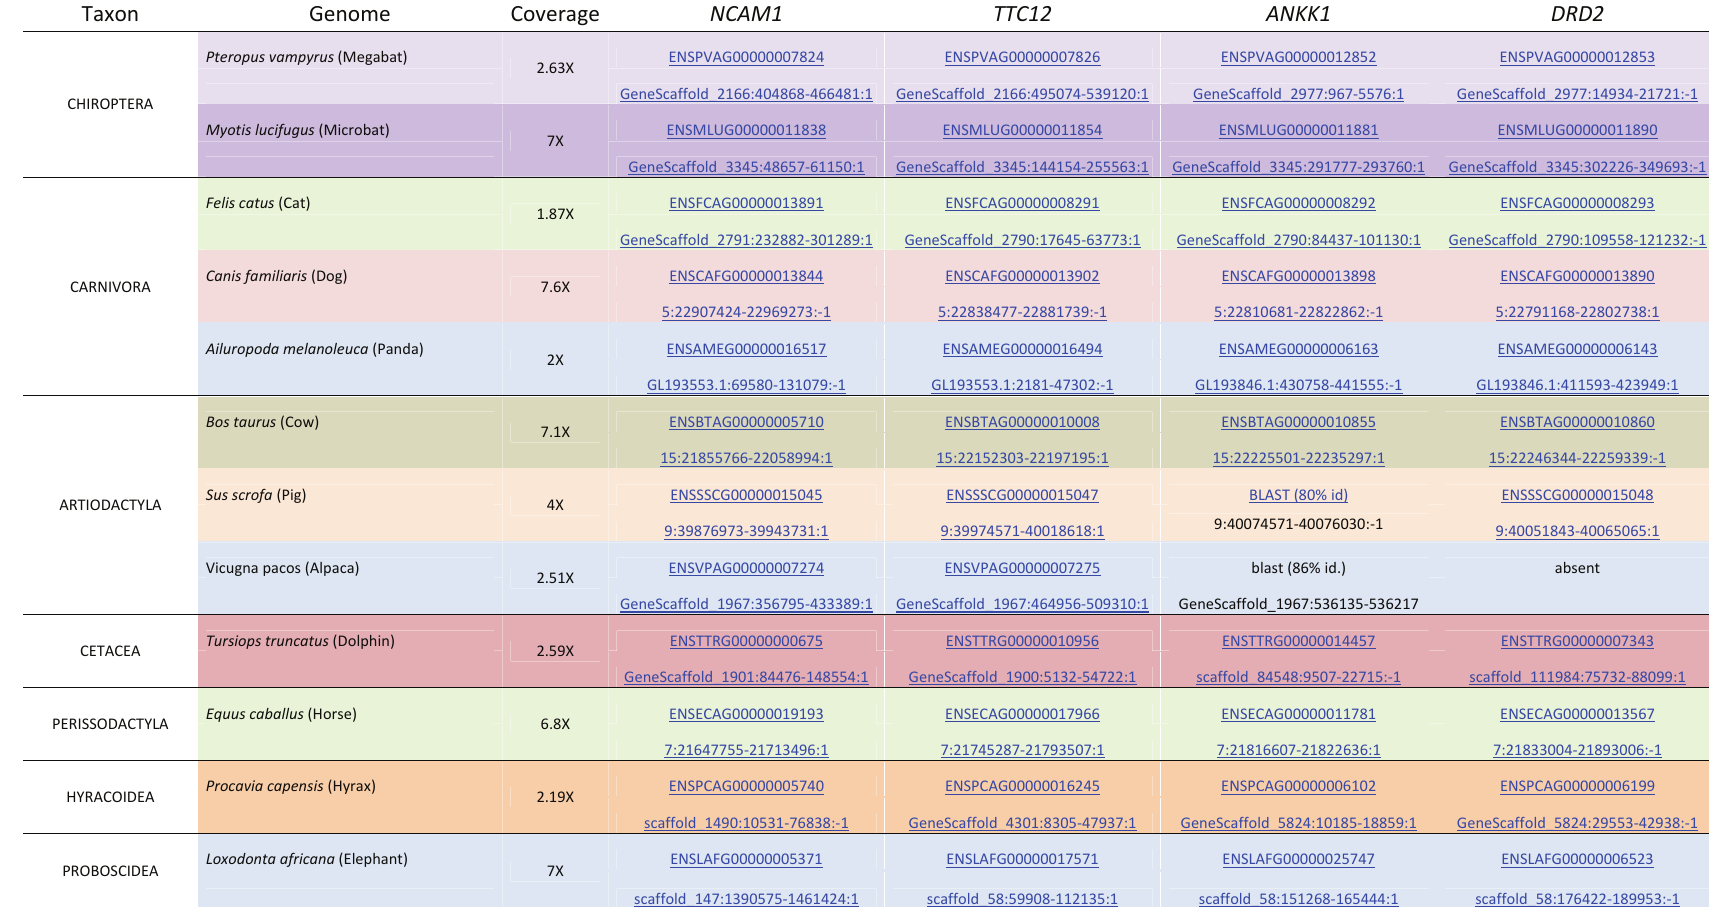
Table S1 (cont). Orthologues of genes in the NTAD cluster in 47 available vertebrate genomes, showing accession number and location.